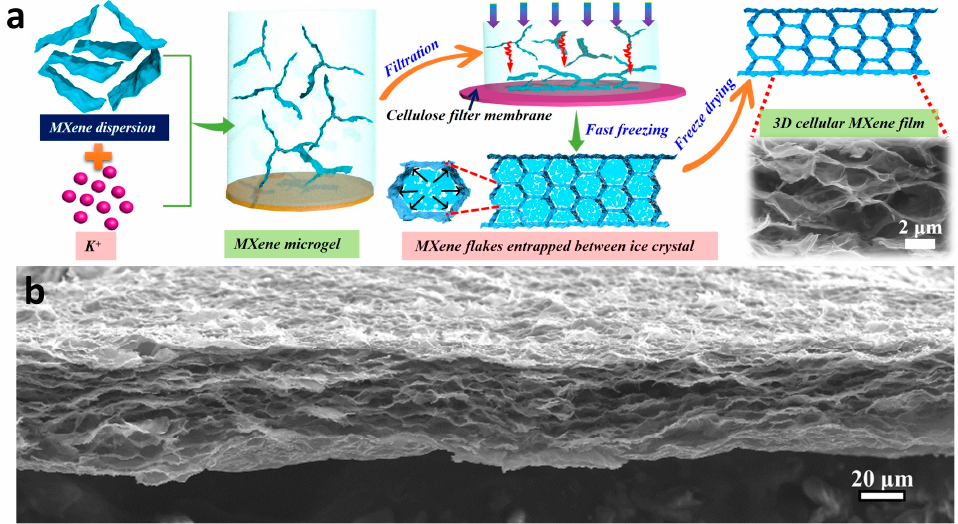
Figure 5. ( a ) Schematic of the preparation process of 3D cellular MXene film. ( b ) Cross-sectional SEM image of 3D cellular MXene film; reproduced from [46], with the permission of the American Chemical Society.